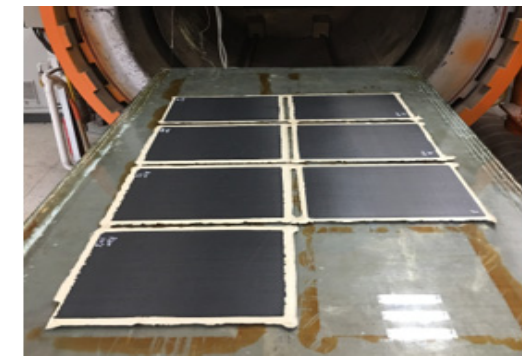
Figure 9. Curing process.